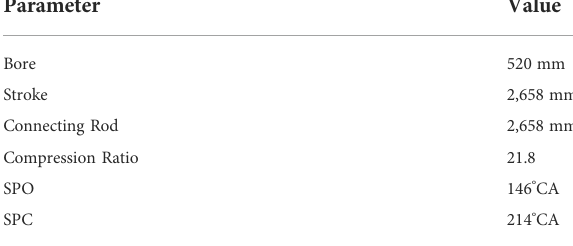
TABLE 6 RTX-8 engine speci fi